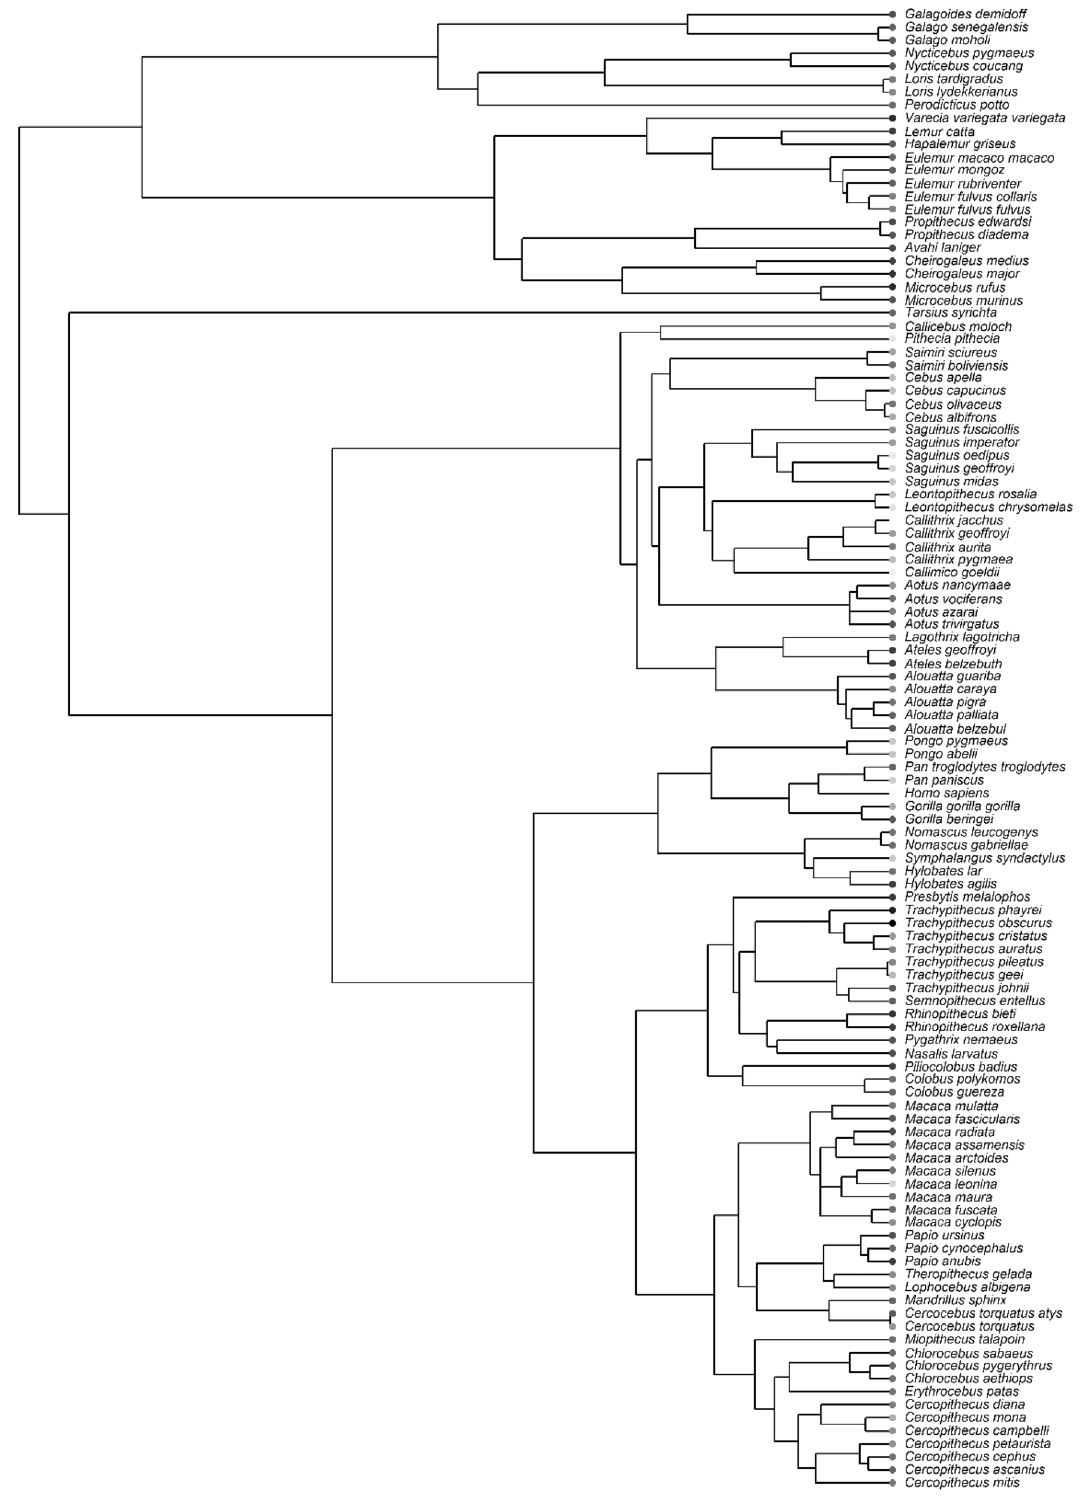
Figure 5. Primate phylogeny with brightness indicator. This shows the phylogenetic relationships between the species used and indicates their scleral brightness. Shade information is